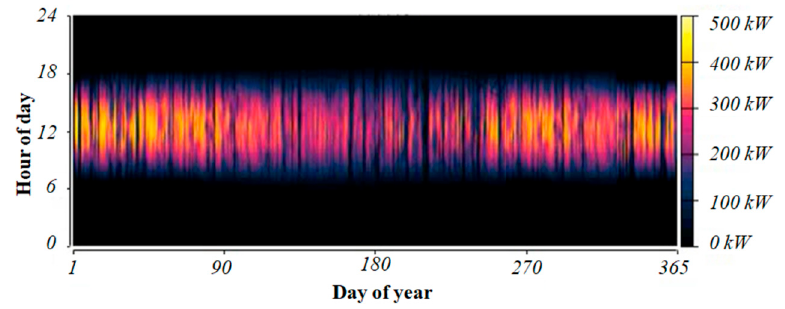
Figure 15. SPV array power output for the PV–BSS configuration.